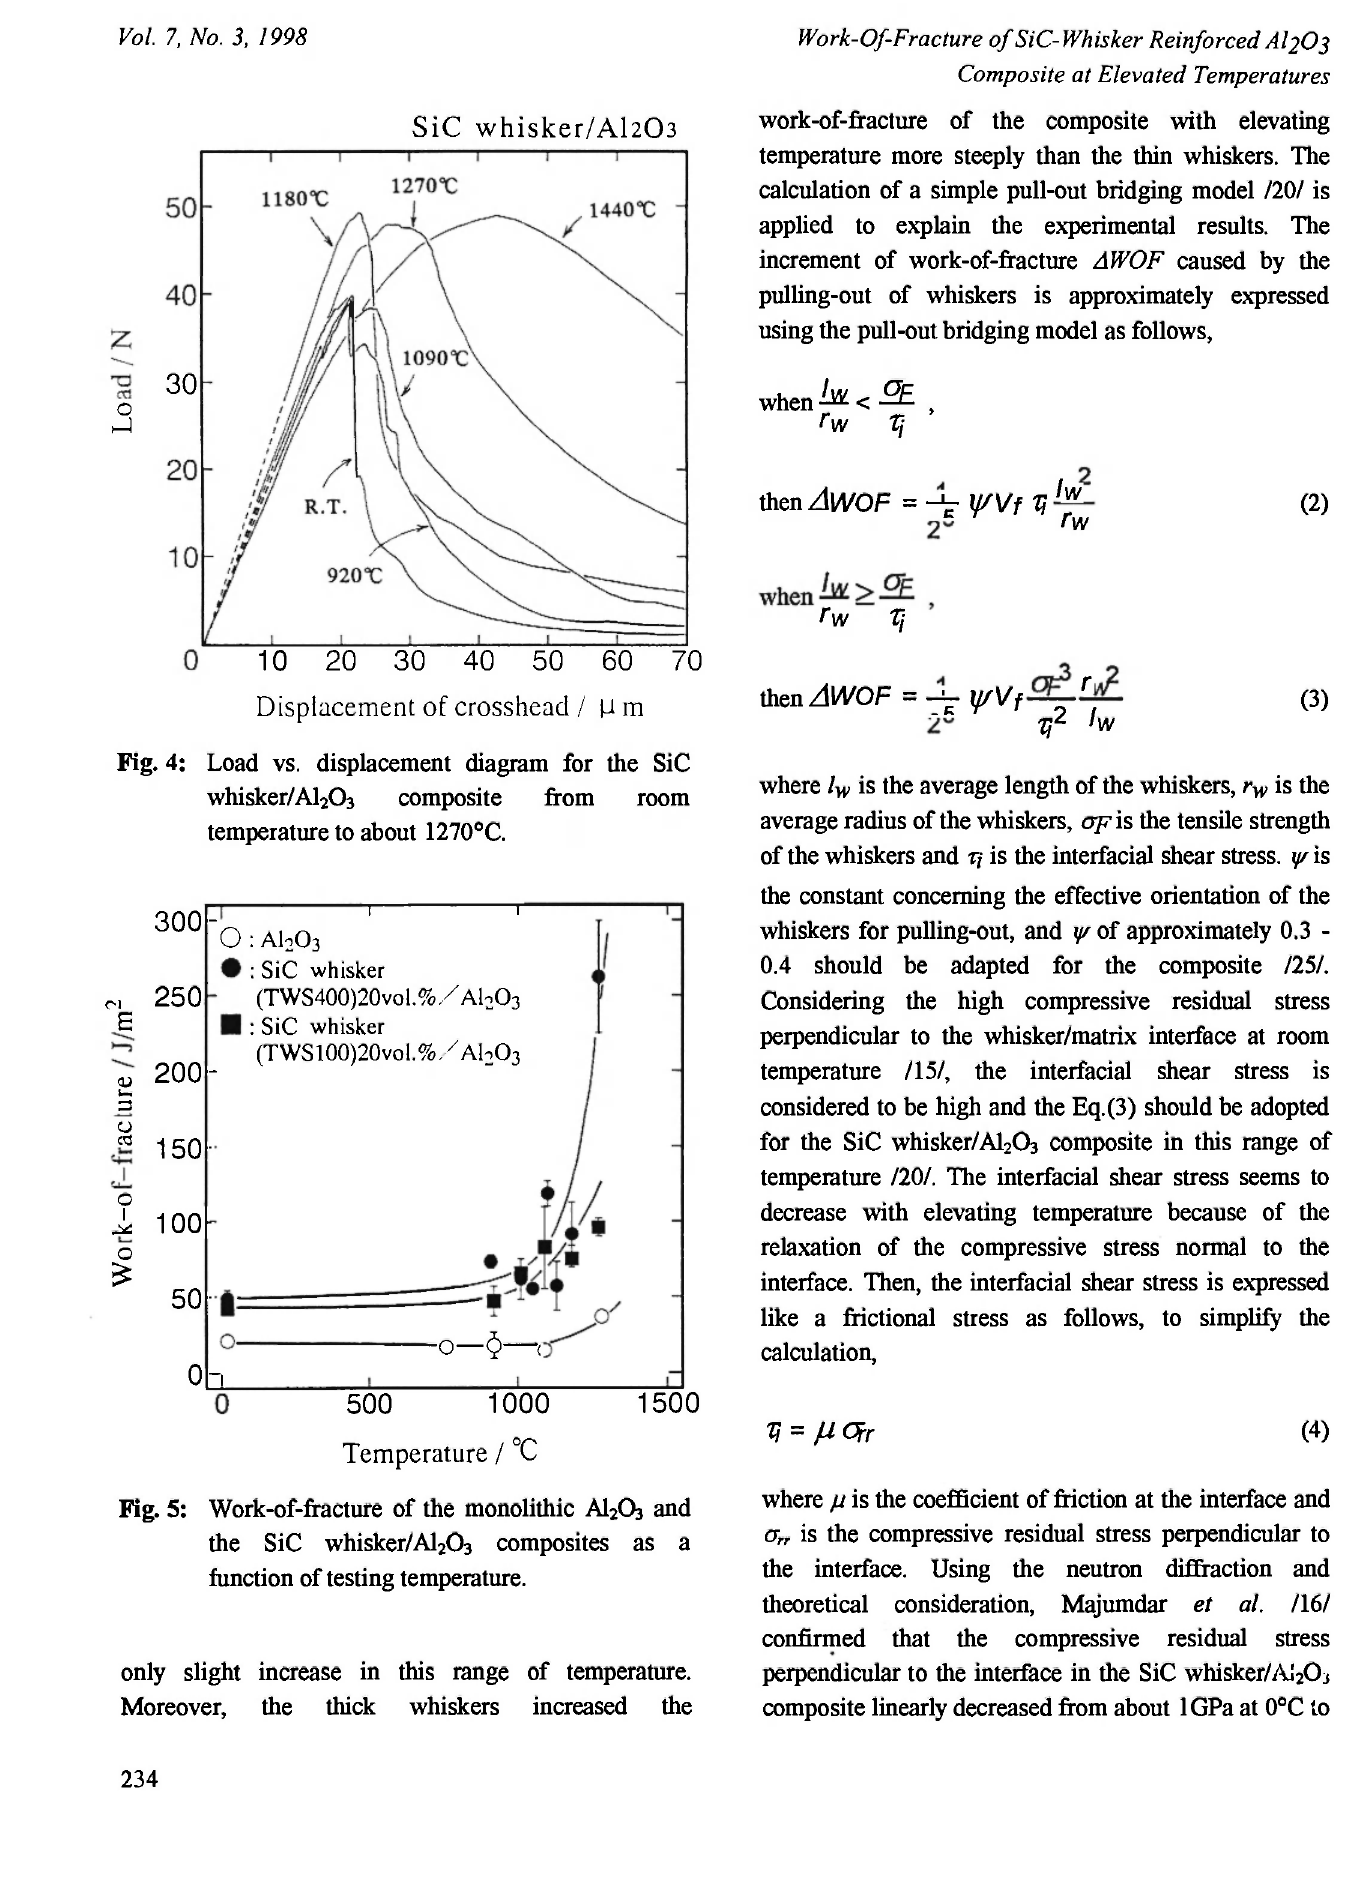
Fig. 5: Work-of-fracture of the monolithic AI2O3 and the SiC whisker/Al function of testing